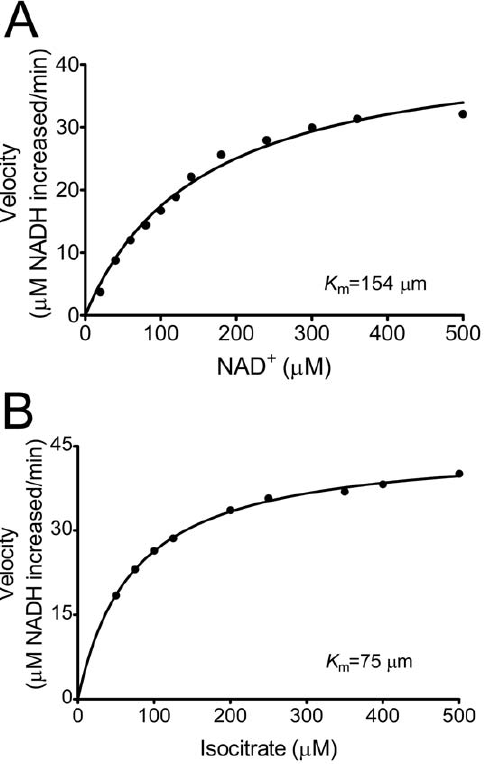
Figure 3. Kinetic analysis of the recombinant SmIDH. The kinetic parameters of the recombinant SmIDH were determined by measuring its enzyme activity at various isocitrate or NAD + concentrations with the other substrate at saturating concentrations. Enzymatic activity was assessed by monitoring the increase of NADH. The SmIDH K m for NAD + (A) and isocitrate (B) were calculated as 154 m M and 75 m M, respectively, by averaging values from triplicate experiments.